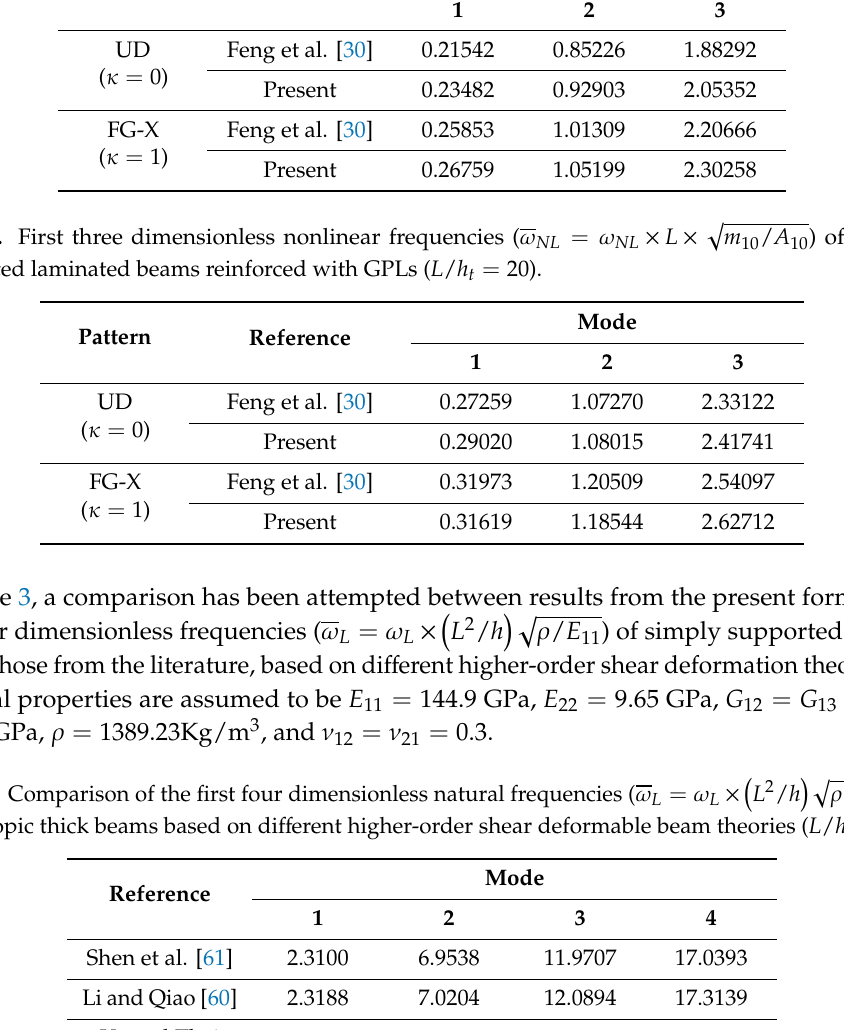
(cid:112) m 10 / A 10 ) of simply supported